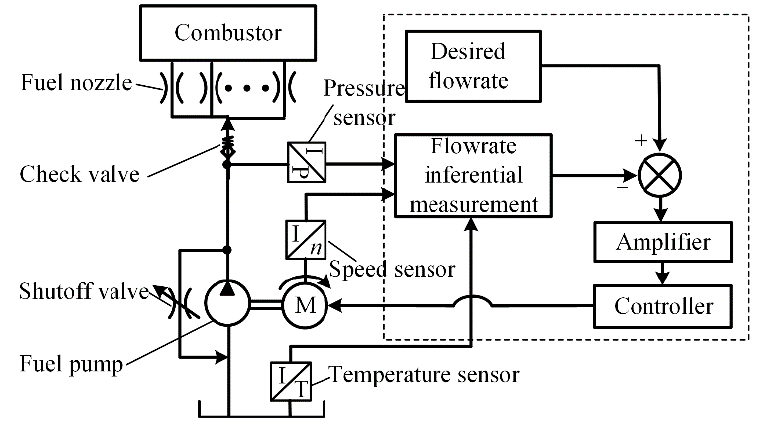
Figure 7. Schematic of a novel FCS with motor-based flowrate control.